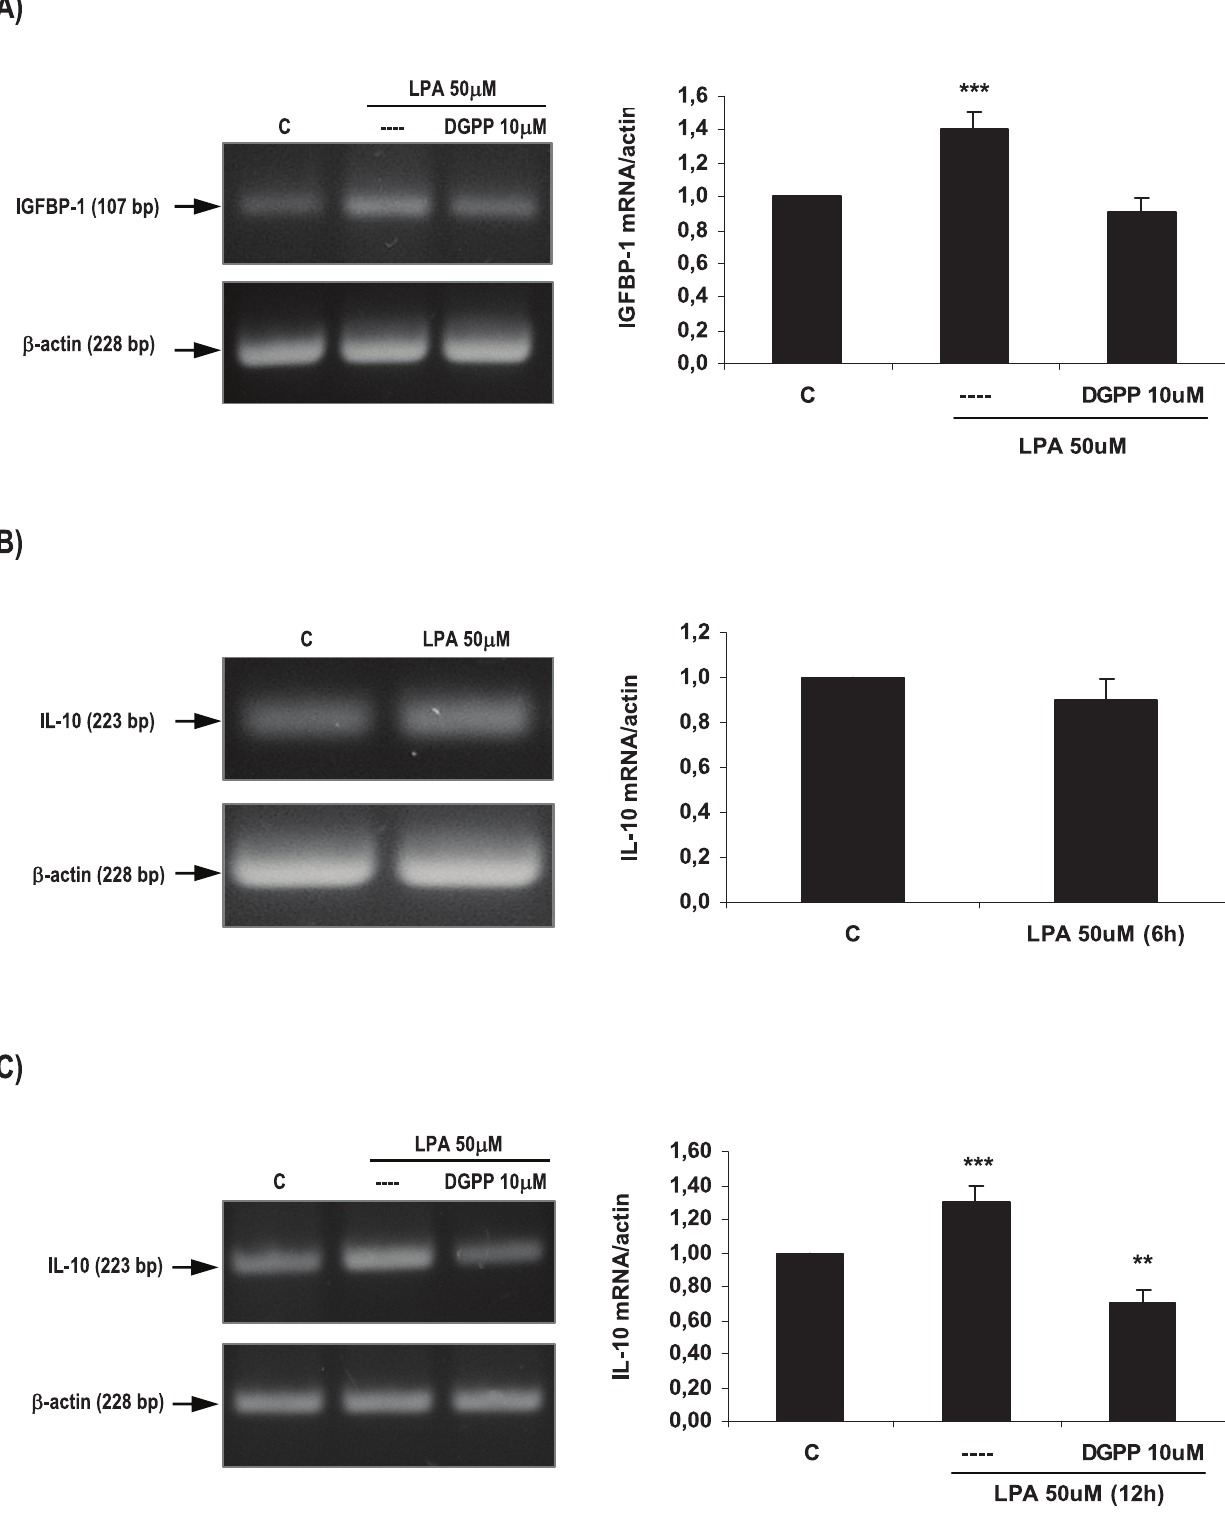
Figure 8. Effect of LPA on decidualization and vascularization markers in the rat uterus during the window of implantation. Uterine strips from rats pregnant on day 5 of gestation (implantation window) were incubated with LPA 50 m M for 6 and 12 h and the expression of IGFBP-1 (A) and IL-10 (B and C) was studied. In A: *** p , 0,001 vs the rest; In C: *** p , 0,001 vs the rest, ** p , 0.01 vs C. Results are shown as means 6 sem. N=4–6 for each point. C: control.